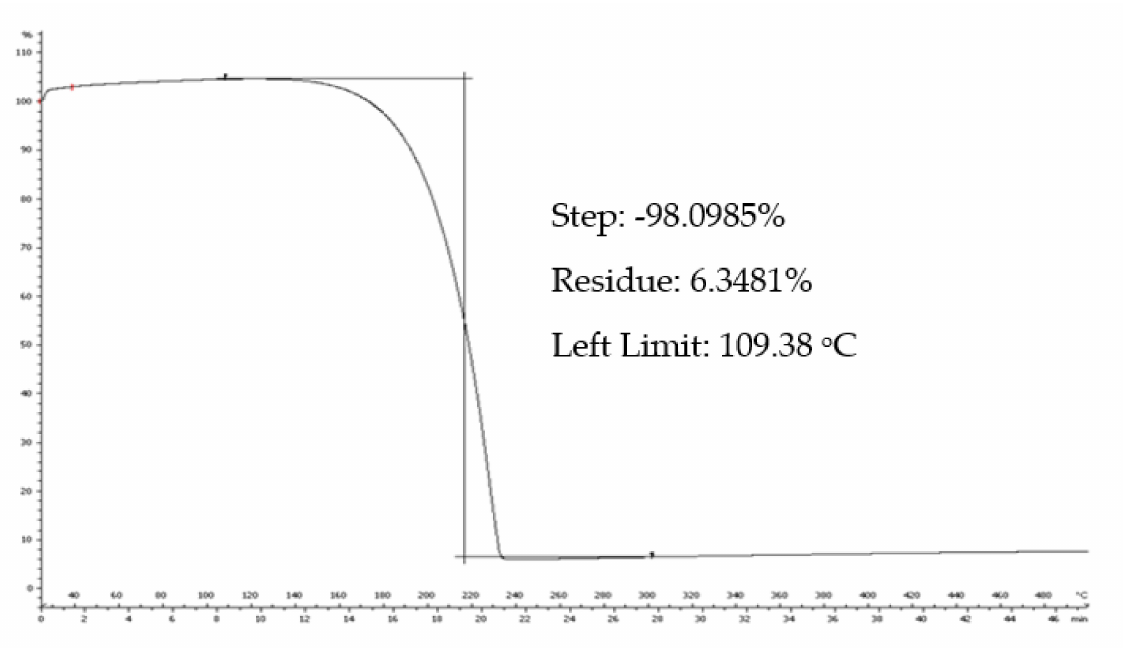
Figure 10. The TGA thermogram of tyrosol.